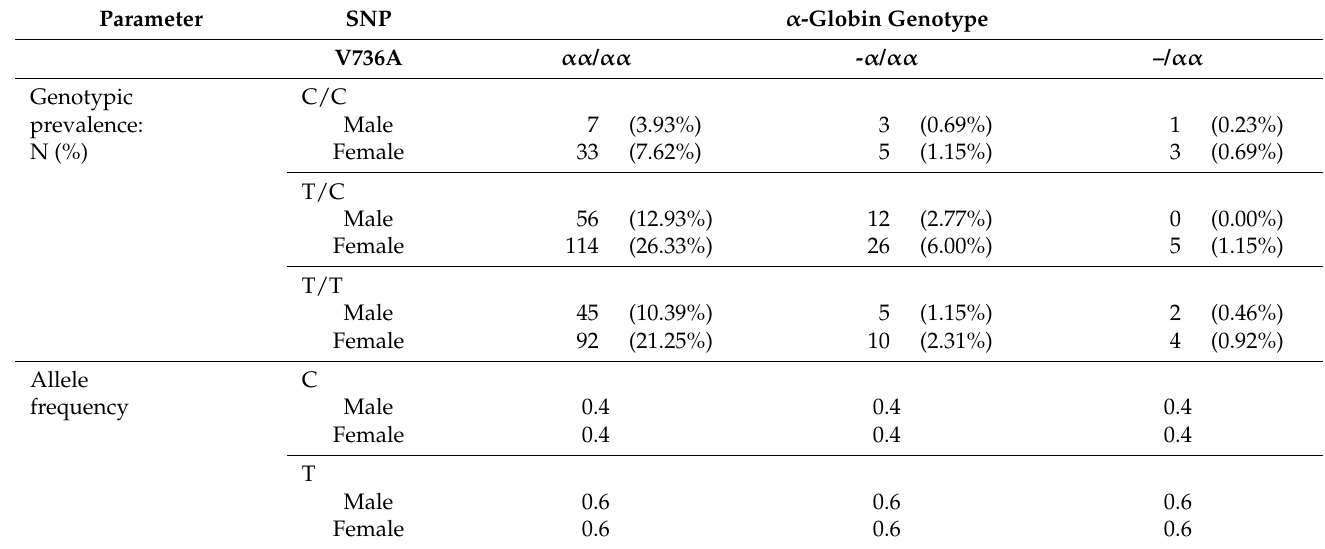
Table 2. Genotypic prevalence and allele frequency of SNP rs855791 of TMPRSS6